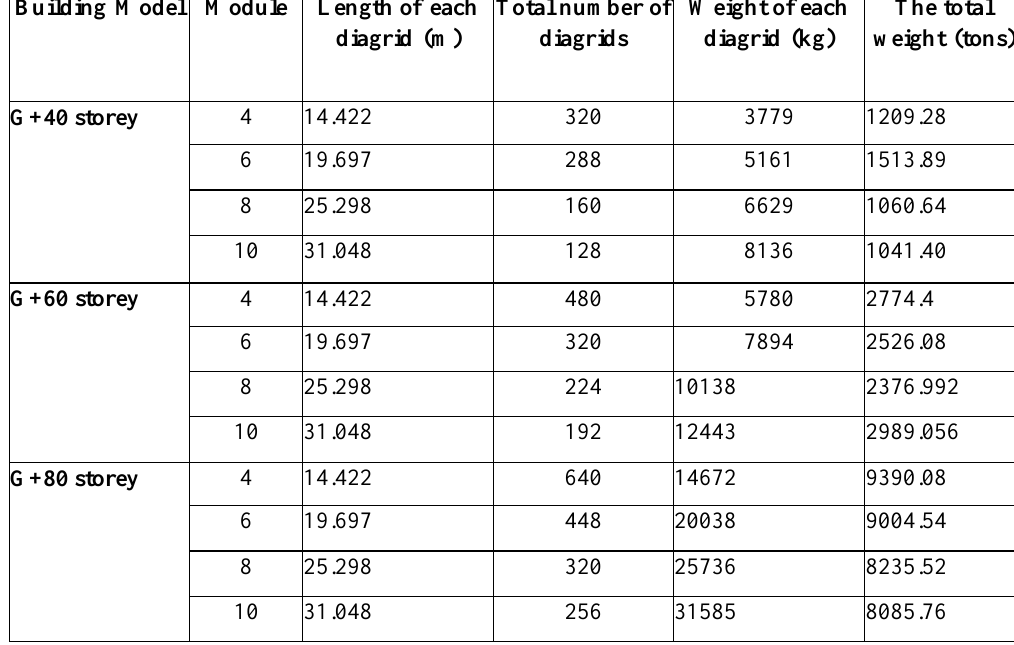
Table 3 Structural steel quantity of perimeter diagrids. Building Model Module Length of each